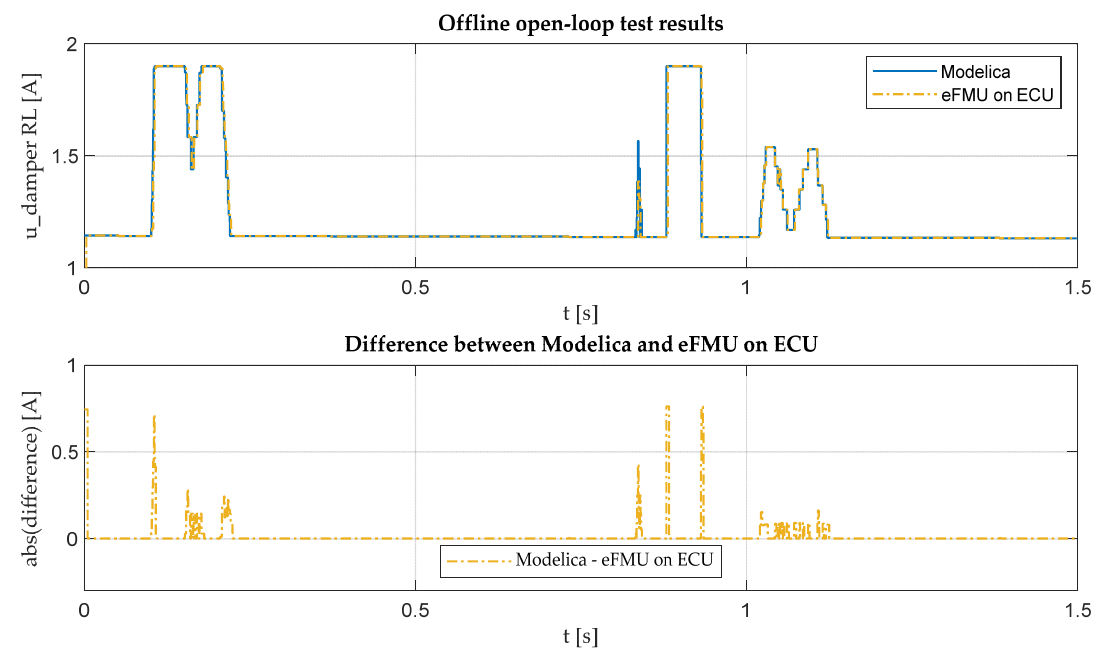
Figure 12. Results from open-loop tests of the original Modelica model and the complete controller eFMU executed on the ECU. Electric currents (u_damper) for the rear left (RL) damper.